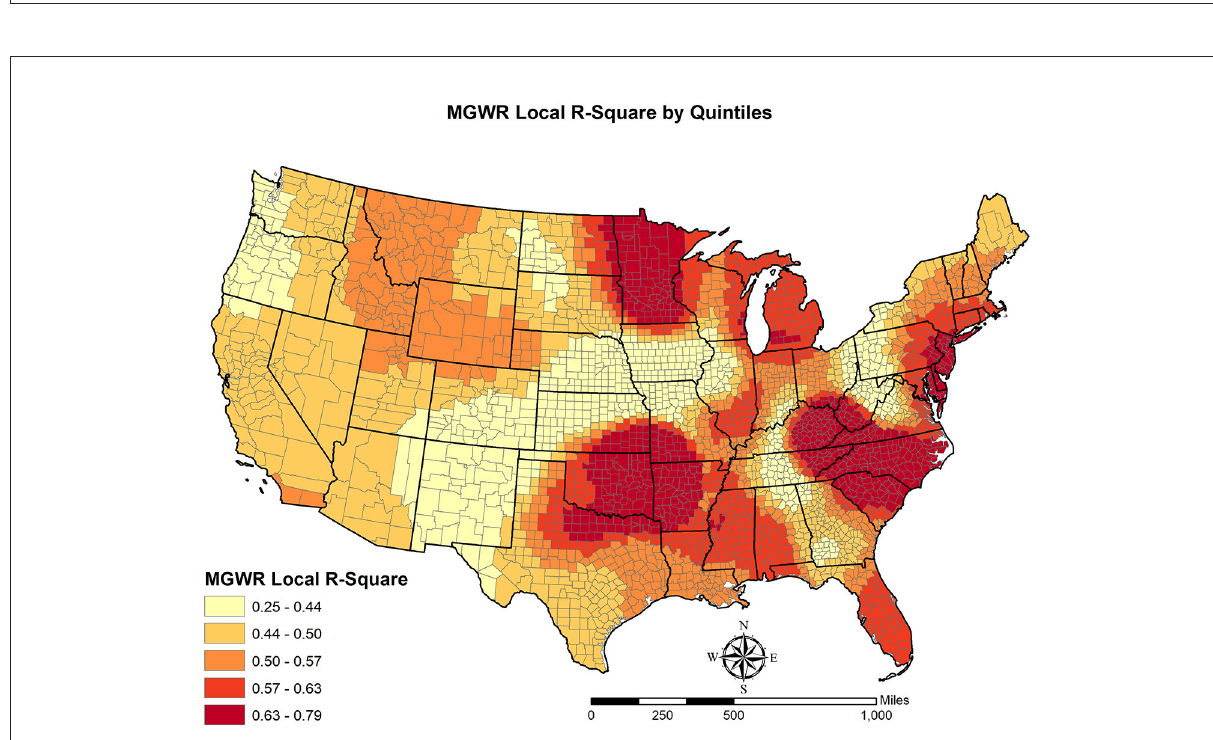
FIGURE4 Local R-squares based on the multiscale geographically weighted